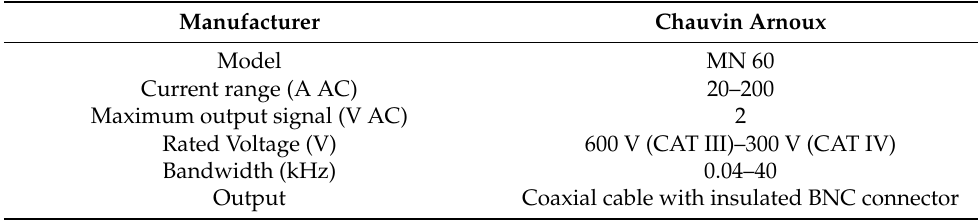
Table 6. Main characteristics of the current